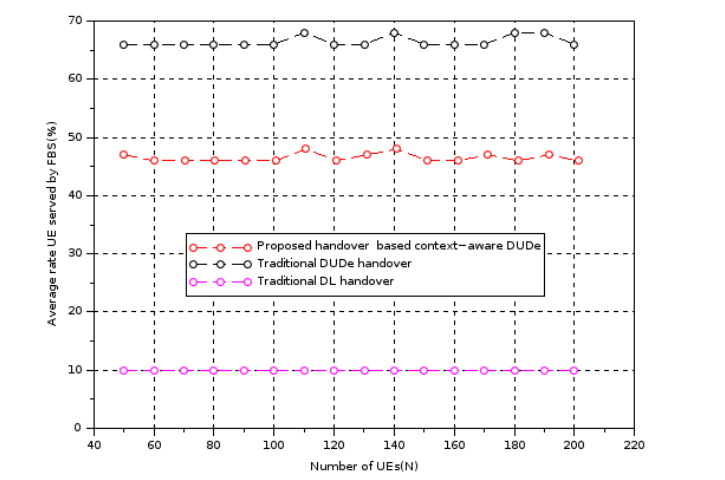
Figure 3. The average rate of UEs served by femto BSs (FBSs) in terms of the total number of